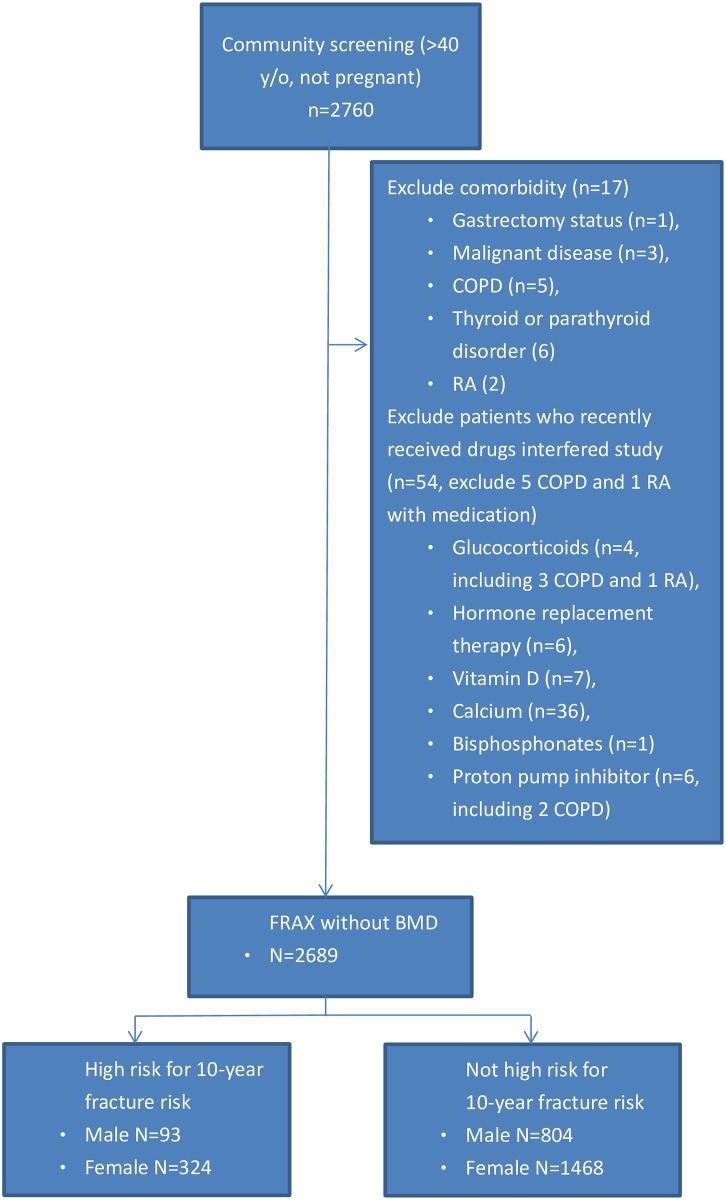
A flow diagram of participants.There were five participants with chronic obstructive pulmonary disease (COPD) and two participants with rheumatoid arthritis (RA). Three participants with COPD and 1 with rheumatoid arthritis who took steroid for disease control. Two participants with COPD took PPI for chronic cough possibly related to gastroesophageal reflux disease (GERD). Another one patient with RA did not take steroid.